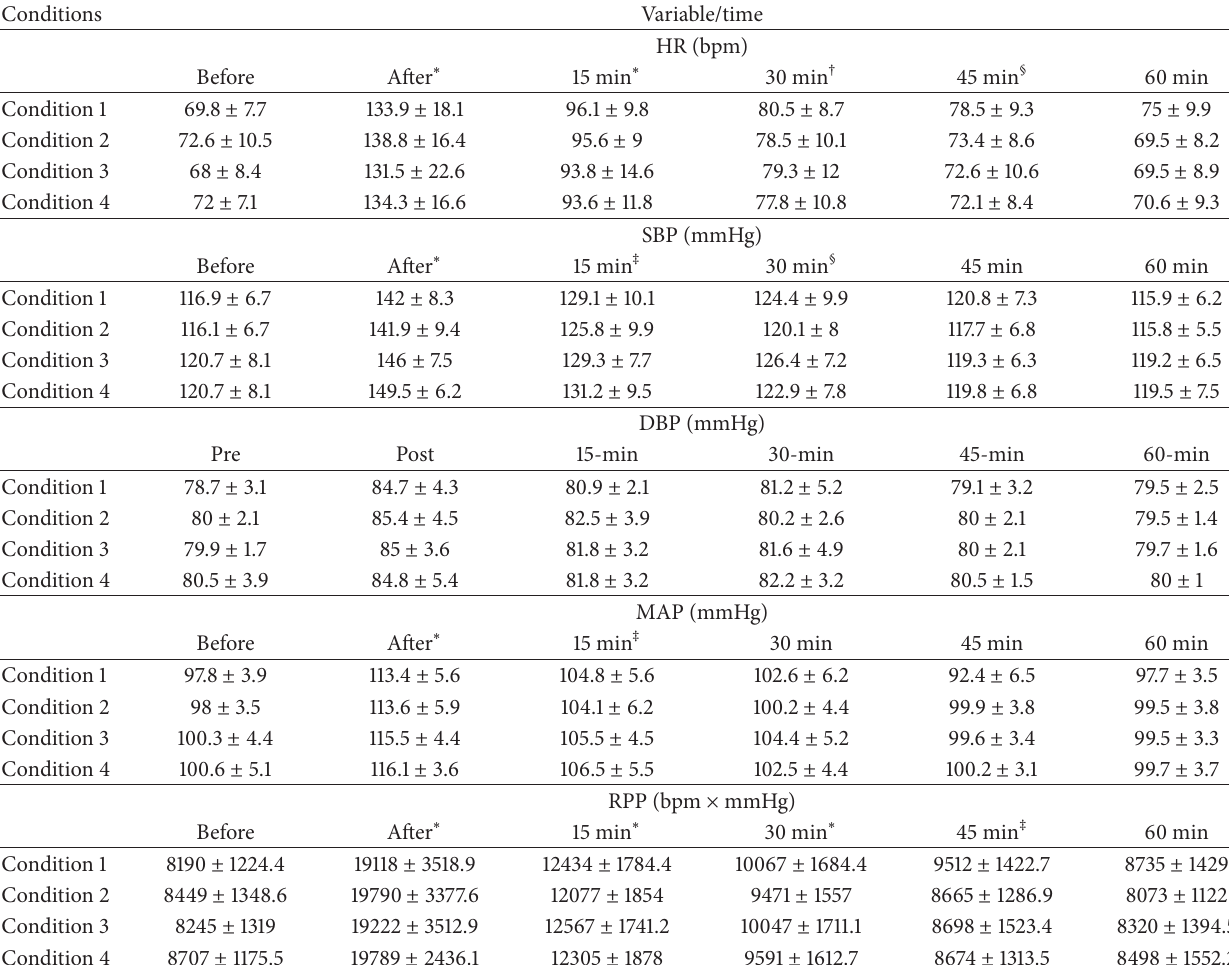
Table 2: Heart rate (HR), systolic blood pressure (SBP), diastolic blood pressure (DBP), mean arterial pressure (MAP), and rate pressure product (RPE) responses to warm-up and resistance exercise with and without of music. Values are mean ±